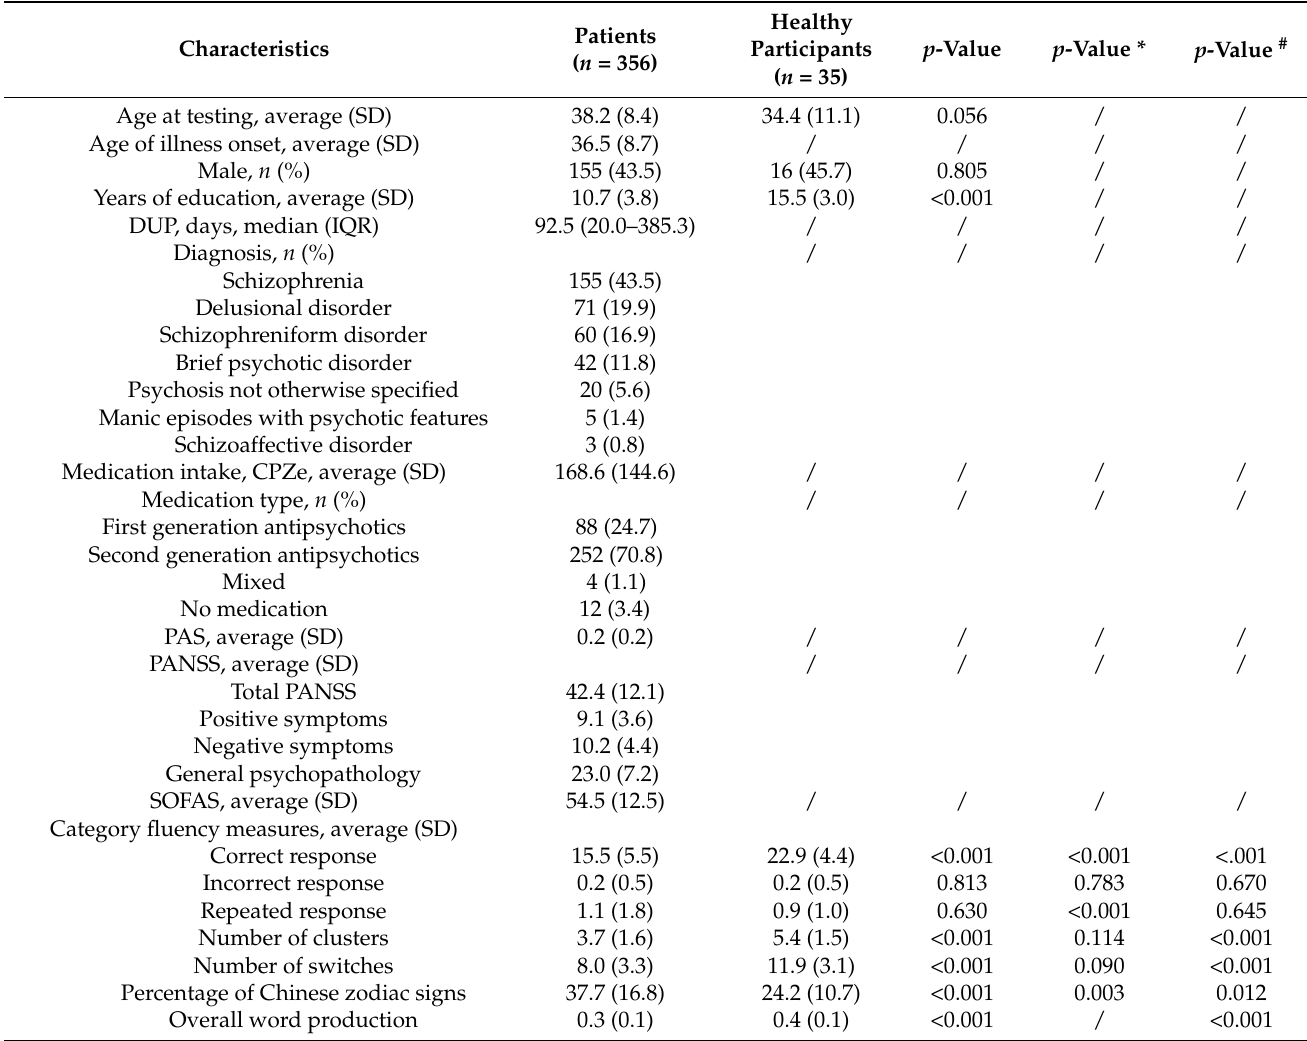
Table 1. Basic characteristics and category fluency performance in first episode psychosis patients ( n = 365) and healthy participants ( n =